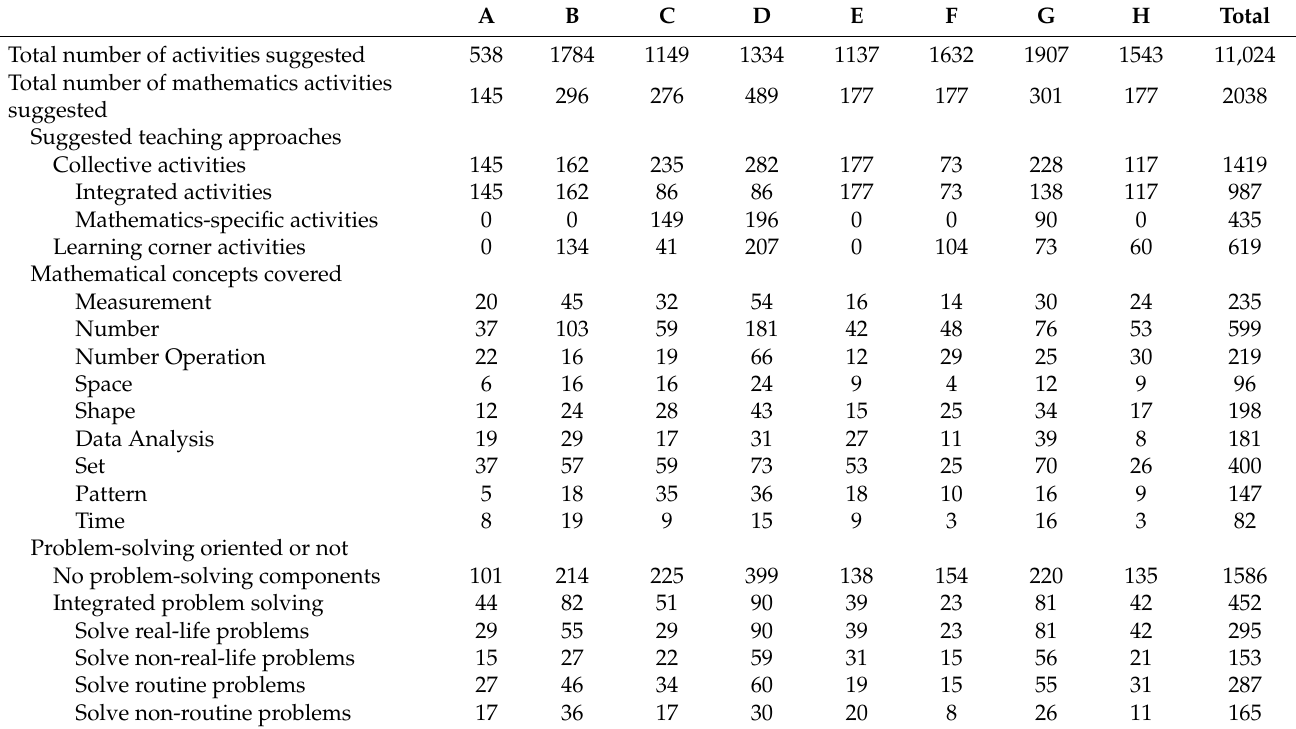
Table 2. The distribution of different mathematics activities covered in kindergarten teachers’ teaching reference